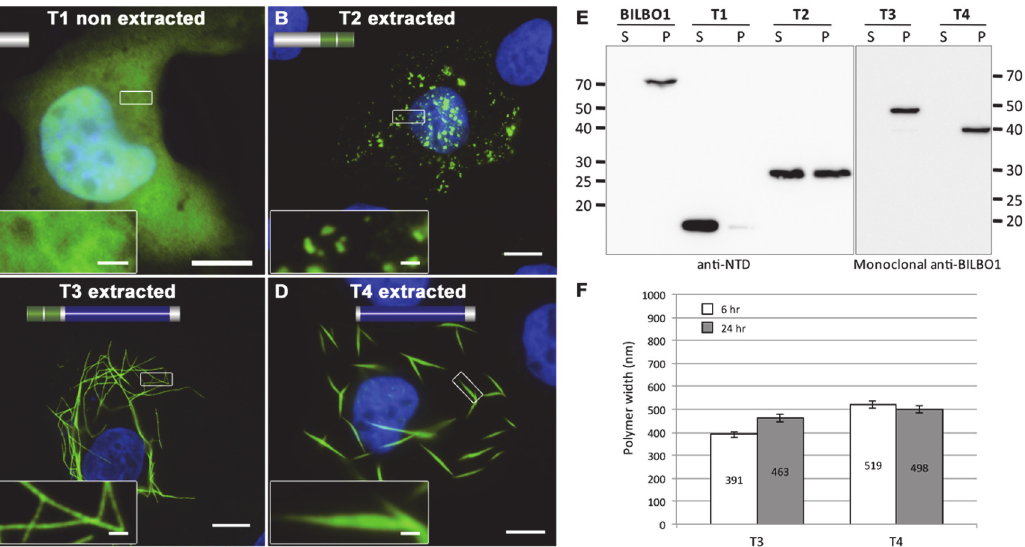
Fig 4. BILBO1 has self-polymerizing properties via its coiled-coil domain. (A-D) Immunofluorescence panels. Heterologous expression of T1 (A), T2 (B), T3 (C), and T4 truncations (D) in U-2 OS cells demonstrate that BILBO1 has self-polymerizing properties via its coiled-coil domain. After 6 hours post- transfection, cells expressing the different constructs were immunolabelled using anti-NTD (T1, T2) or 5F2B3 (T3, T4). The inserts in the bottom left of panels represent higher magnifications of structures observed in these panels. Scale bars represent 10 μ m, and 1 μ m in magnified insets. (E) Western blots probed with anti-NTD (BILBO1, T1, T2) or 5F2B3 (T3, T4) against proteins samples collected from U-2 OS cells after six hours of expression. Samples were collected from pellet and supernatant of detergent extracted cells. BILBO1, T3 and T4 are insoluble. T1 is primarily soluble and T2 is partially soluble. Predicted relative molecular masses (using ExPASy compute pI/Mw) of truncations are T1 = 19kDa, T2 = 25.25kDa, T3 = 48.3kDa, T4 = 39kDa. (F) Measurements of structure width in polymers formed by T3 and T4 truncation at six and 24 hr post-transfection.